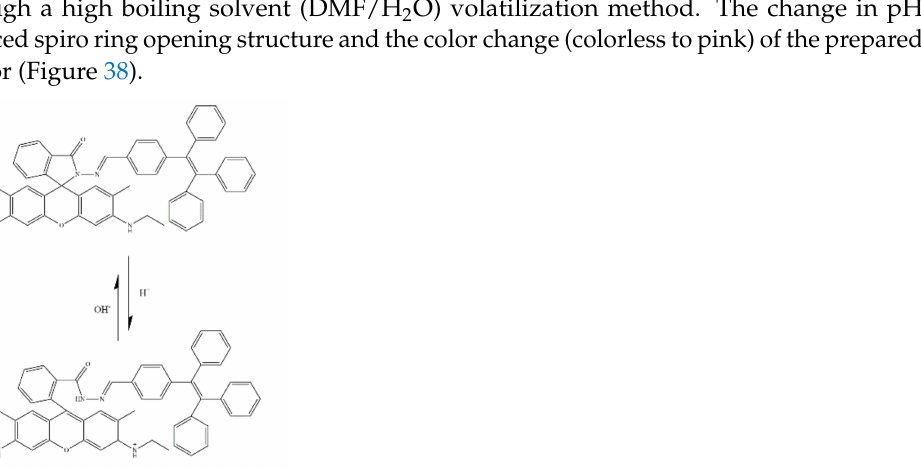
Figure 38. The concluded sensing mechanism of this prepared sensor (Table 2, No. 6) for pH